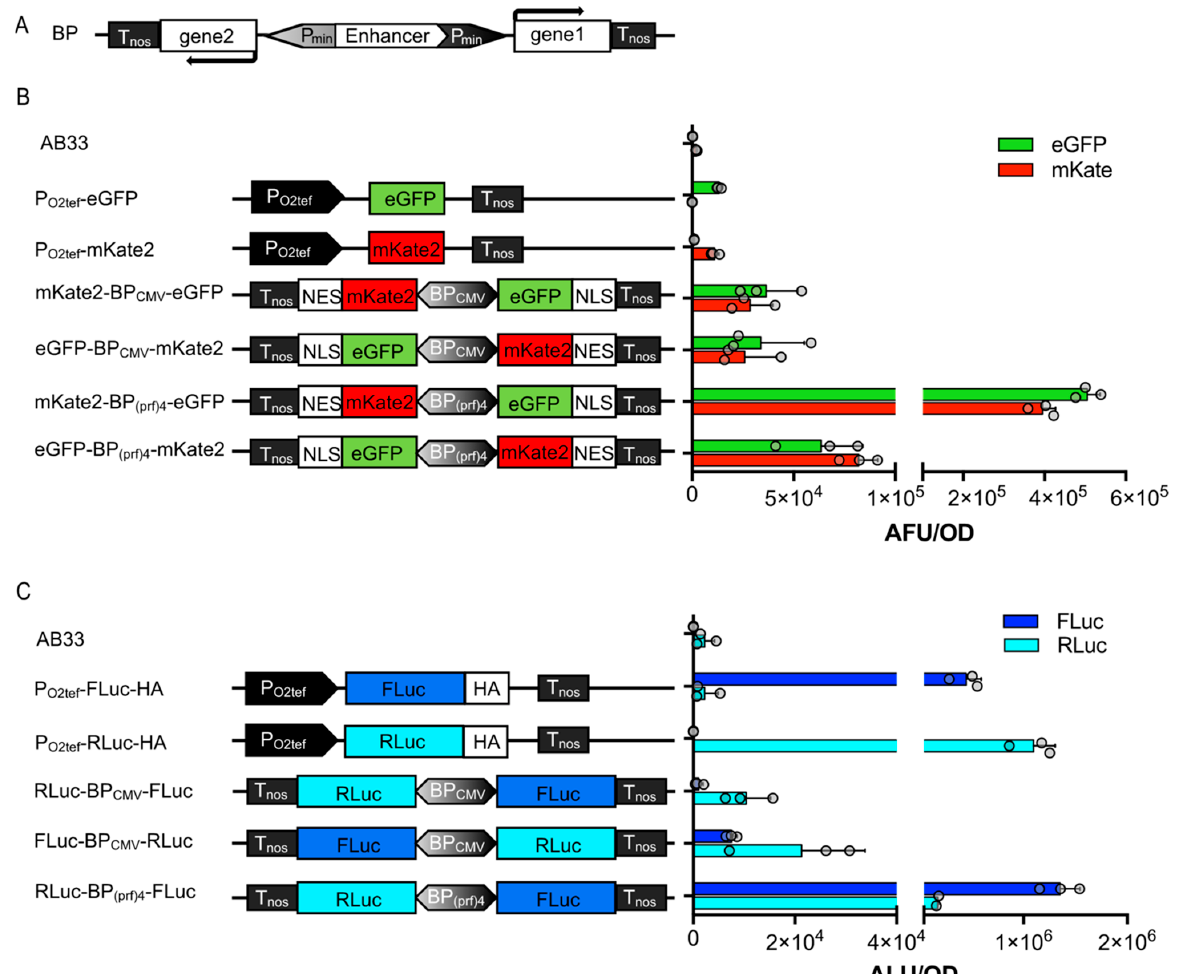
Figure 3. Establishment of bidirectional promoters in U. maydis . ( A ) Configuration of constructs with bidirectional promoters that have been transformed into the upp3 locus of AB33. The minimal promoter that is located upstream of the enhancer is on the light-gray end of the bidirectional promoter (grayscale gradient). ( B ) Fluorescence intensity of strains determined in cultures of an OD 600 = 0.5. ( C ) Absolute luminescence of cell lysates from 2 mL cultures; both controls and BP strains were adjusted to OD 600 = 0.5. Error bars represent the SEM of the individual experiments with n =